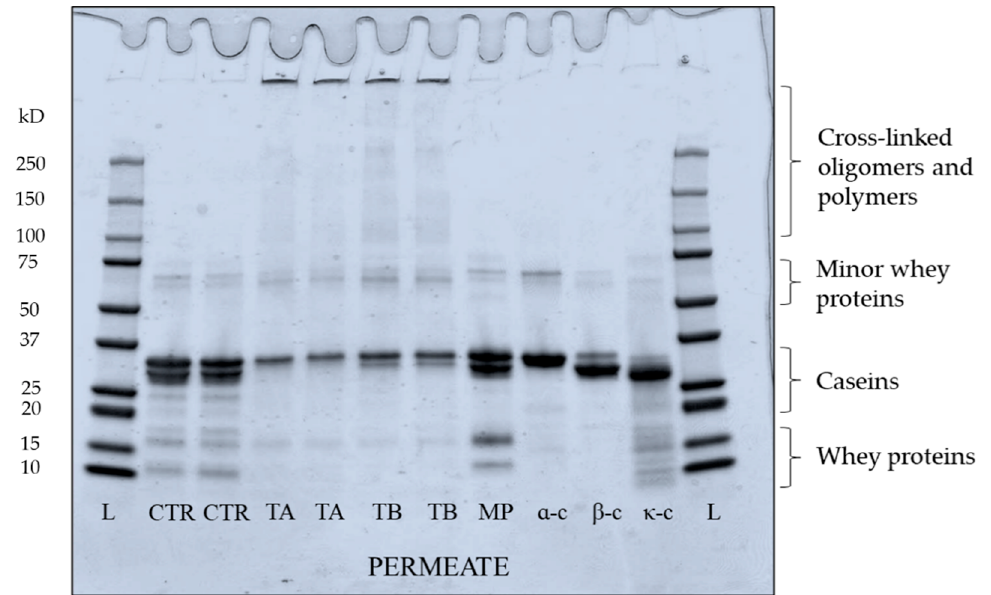
Figure 8. Electrophoretic pattern under reducing conditions of permeate samples produced by microfiltration of mTG crosslinked micellar casein concentrate feed at 5 ± 0.5 °C. Bands represent samples from two independent runs at each treatment. L: ladder; CR: CTR; TA: 5 °C/24 h; TB: 40 °C/90 min; MP: low heat skim milk powder; α -c: α s -casein; β -c: β -casein; κ -c: κ -casein.